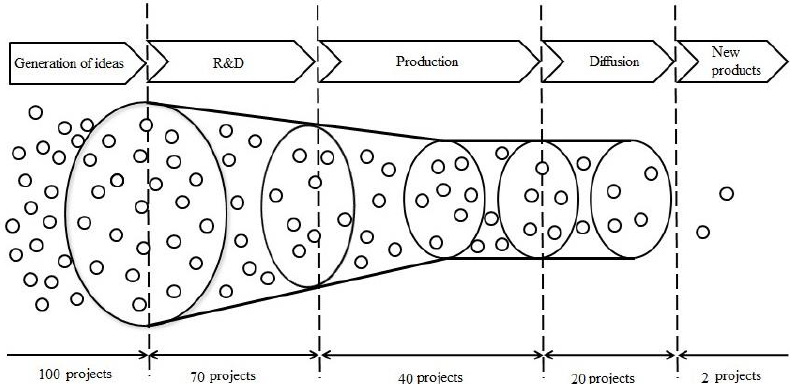
Fig. 1. The overall process of innovation